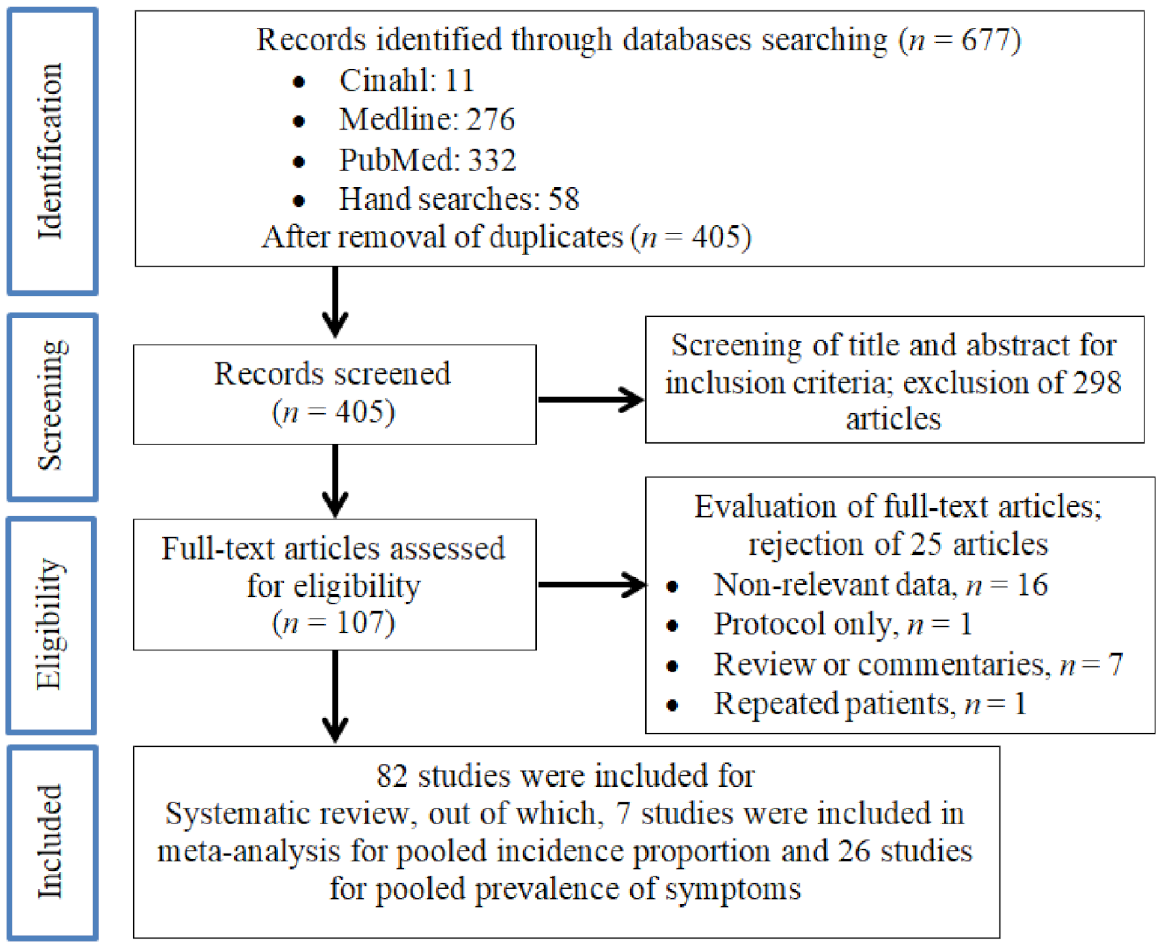
Figure 1. Preferred Reporting Items for Systematic Reviews and Meta-Analyses (PRISMA) flow diagram of the literature screening